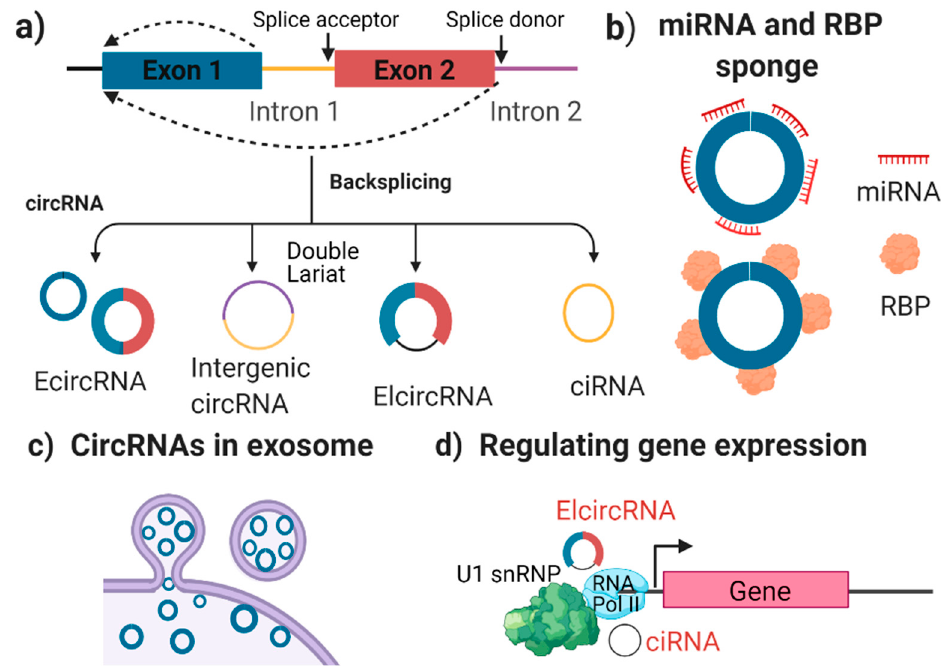
Figure 2. The biogenesis ( a ) and potential function ( b – d ) of circular RNAs. ( a ) Four types of circRNAs created via back splicing — ecircRNA, intergenic circRNA, elcircRNA, and ciRNA. ( b ) circRNAs can serve as sponges for binding miRNAs or RBPs. ( c ), exosome-derived circRNAs. )( d ) aelcircRNA and ciRNA can regulate gene expression by binding with the RNA Pol II and U1 snRNP complex. RBP: RNA binding proteins; miRNA: microRNA; U1 snRNP: small nuclear ribonucleoprotein; and RNA pol II: RNA polymerase II.